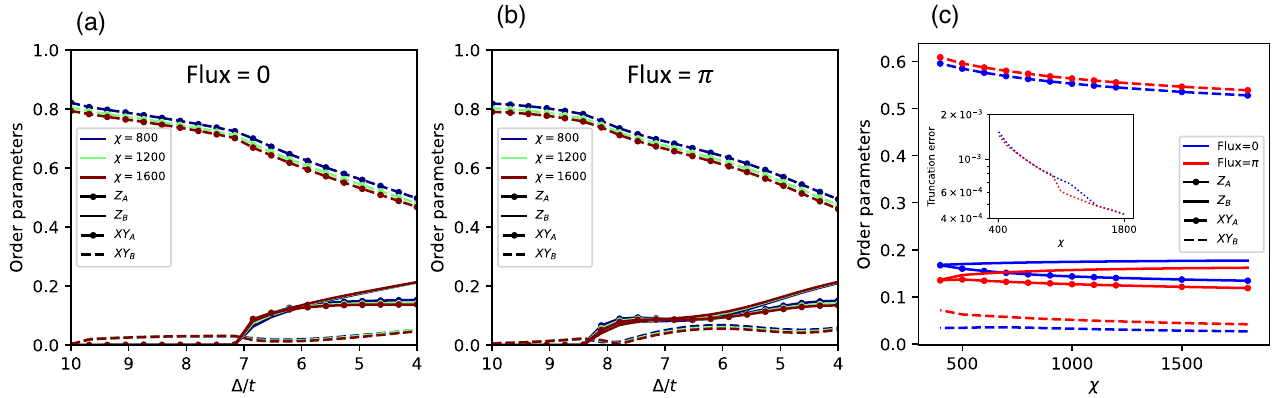
FIG. 7. Plot of the ordered parameters as a function of Δ obtained from DMRG for (a) zero and (b) π flux threaded through the cylinder. In panel (c), we fix Δ ¼ 5 t and show the order parameters as a function of bond dimension χ . The inset shows the DMRG truncation error.